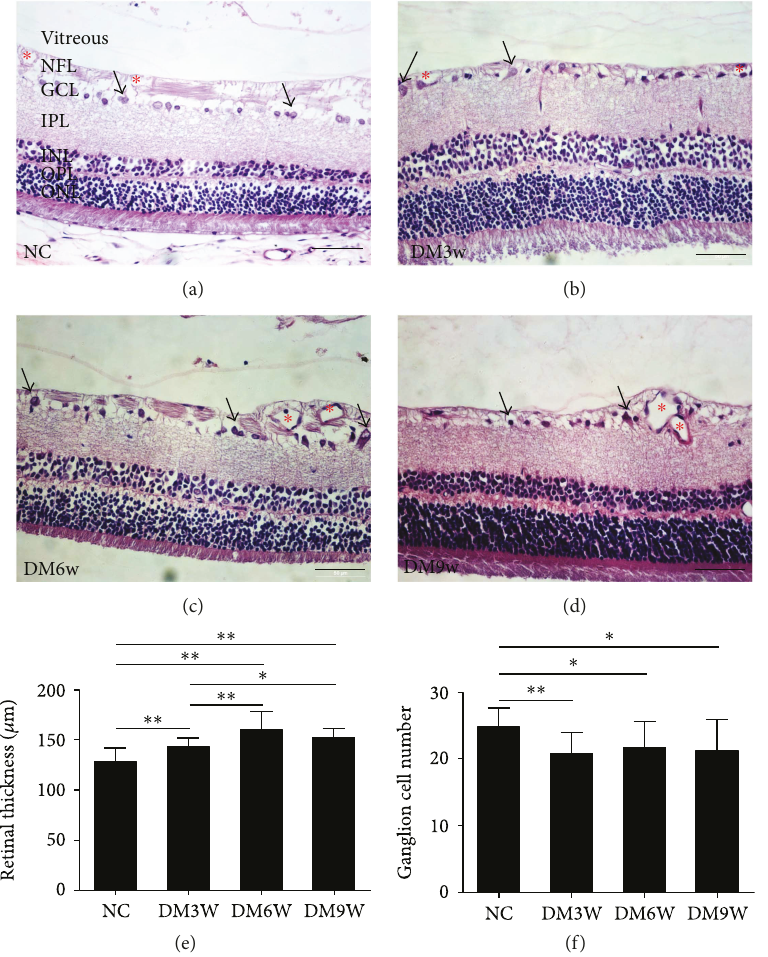
Figure 1: Neuronal and vascular changes in the early stage of diabetes. (a – d) H&E staining of the retina in the NC, DM3w, DM6w, and DM9w groups. Black arrow indicates neuronal changes in which the ganglion cells appeared to be enlarged at the DM3w group but were condensed at the DM6w and DM9w groups. Blood vessels were dilated in diabetic retina notably at the DM6w and DM9w groups (asterisk). (e, f) Quanti fi cation of retinal thickness and ganglion cell number in the NC, DM3w, DM6w, and DM9w groups. Bar =50 μ m. ∗ p < 0 05 and ∗∗ p < 0 01